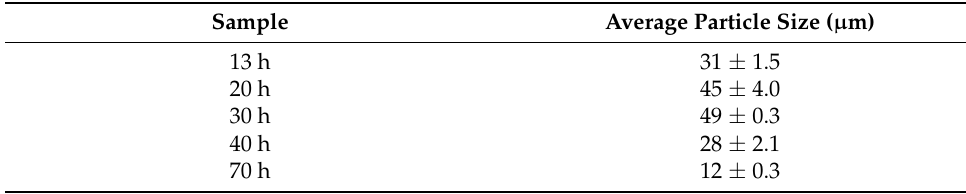
Table 1. Average particle size values with error bars for samples obtained for 13, 20, 30, 40, and 70 h of milled time.